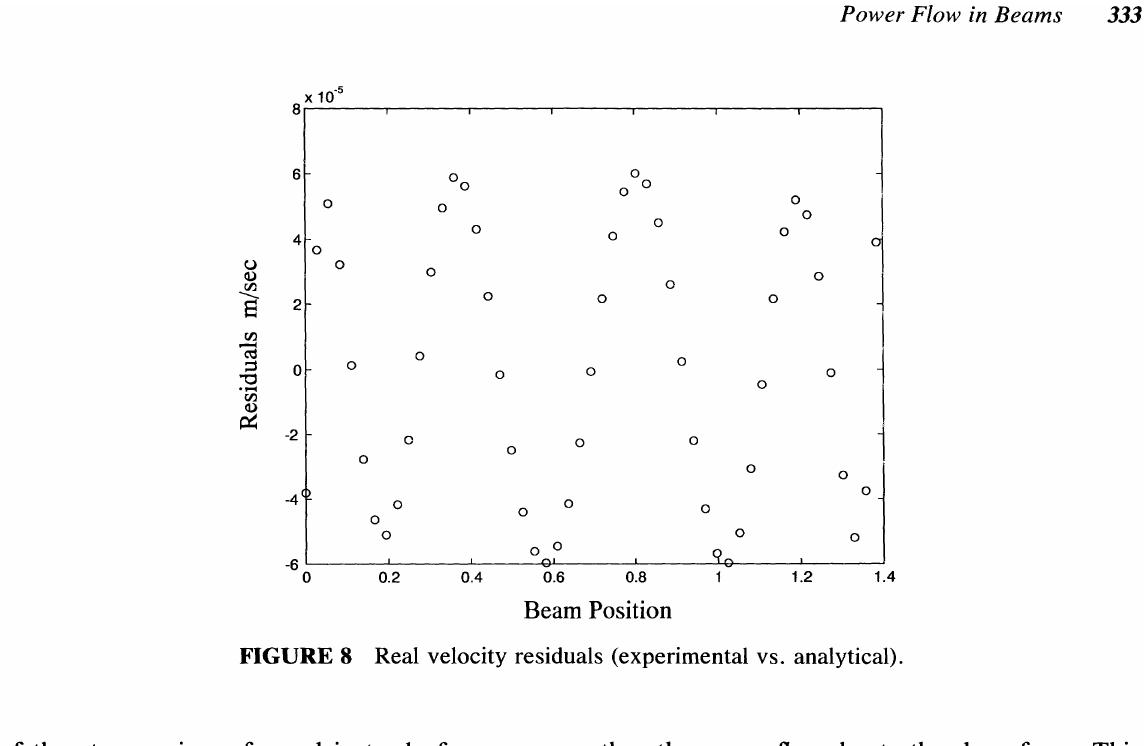
FIGURE 8 Real velocity residuals (experimental vs. analytical).